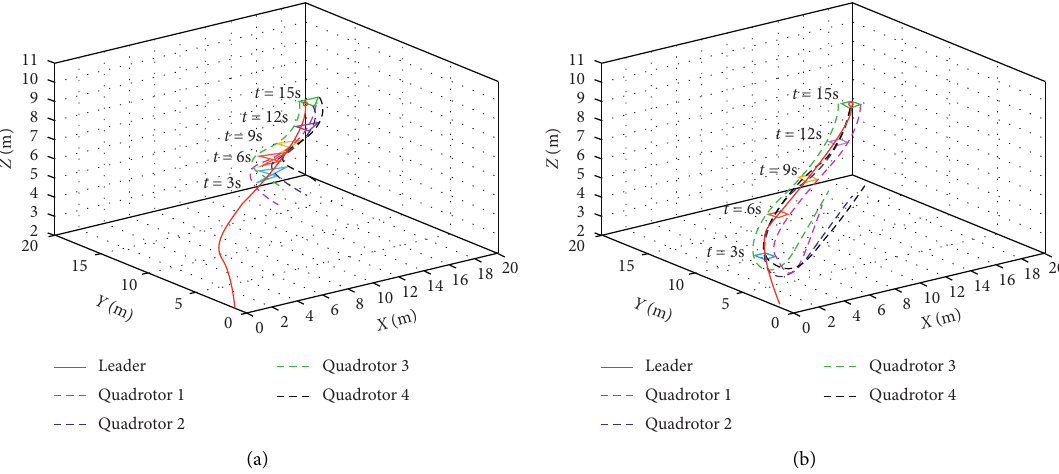
Figure 6: The flight trajectory of all quadrotors in the range of (10, 20). (a) Under the control algorithm (34). (b) Under the control algorithm